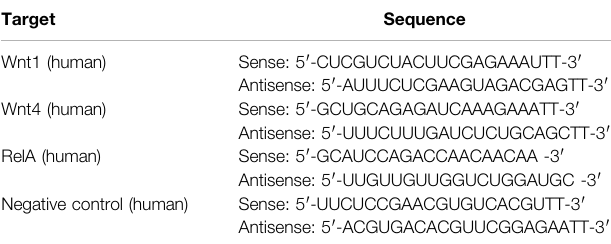
TABLE 1 | siRNA sequences targeting Wnt1 and Wnt4.